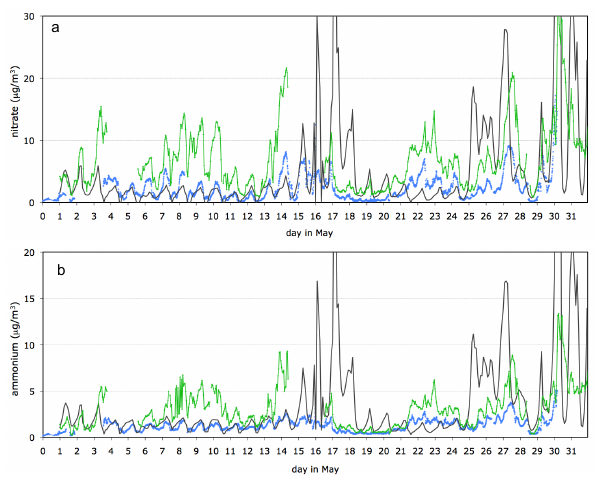
Fig. 10. Observed (blue, green; see Fig. 5) and simulated (black) Figure 10. Observed (blue, green; see Fig. 5) and simulated (black) concentrations ( µ g/m 3 ) of a) nitrate, and b) ammonium for the sensitivity study. concentrations (µg/m 3 ) of (a) nitrate, and (b) ammonium for the sensitivity